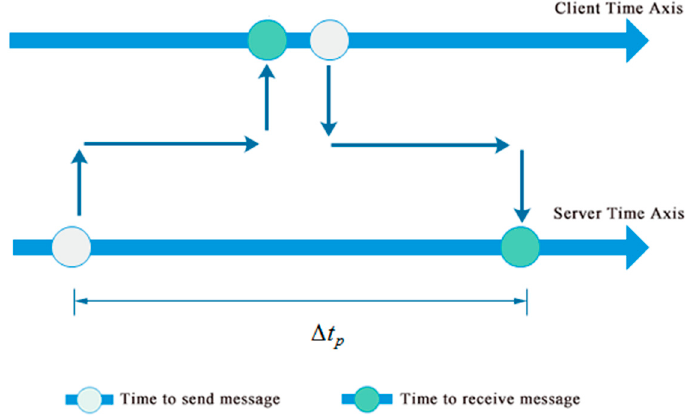
Figure 7. Time analysis of ping command sent by server.